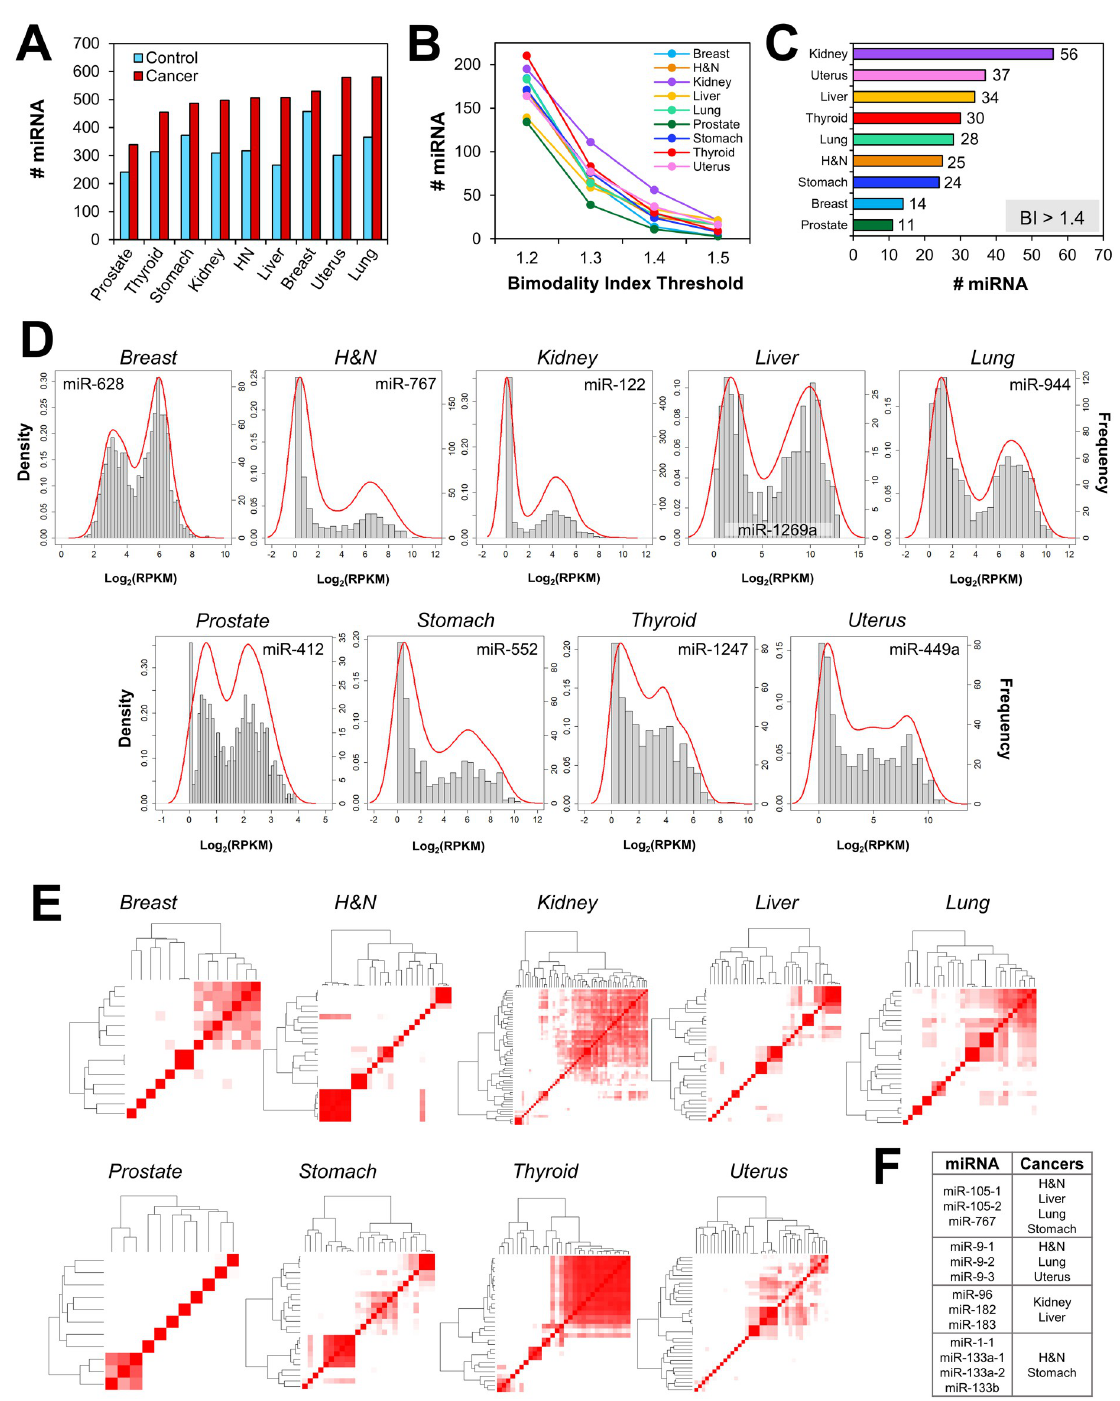
Fig 3. Bimodal miRNA across cancers. (A) Bimodally expressed miRNA were examined in nine types of cancer and control tissue using mixture modeling (MM). Bimodality was also examined in cancer tissue using controlled mixture modeling (CM), and (B) the number of bimodal miRNA at various bimodality index thresholds are reported, as well as (C) a more detailed report of bimodal miRNA having a bimodality index (BI) > 1.4. (D) The top-ranked bimodal miRNA from each cancer type were visually inspected for bimodality. (E) Within each cancer type, correlations were calculated between bimodal miRNA in order to identify modules of concurrently expressed bimodal miRNA. High correlations are represented in red. (F) Four concurrent expression modules were common to multiple cancer types.